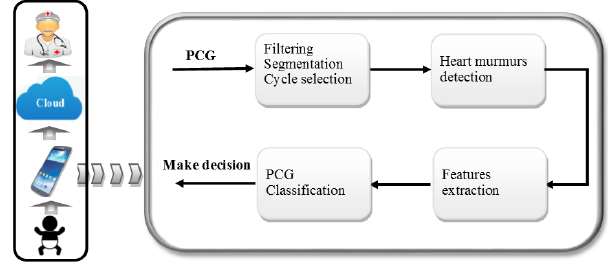
Figure 2: PhonoSys implementation scheme.